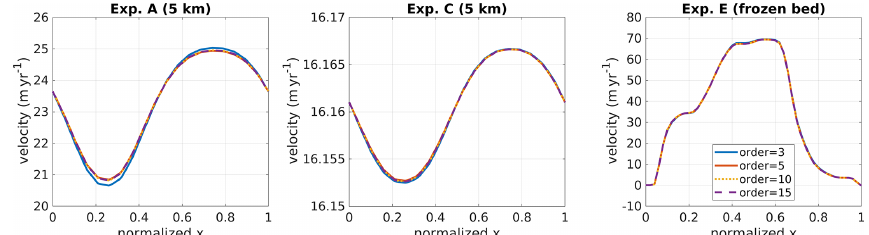
Figure A1. ISMIP-HOM experiments: surface velocities for experiments A, C, and E obtained with the MOLHO model using different inte- gration orders for the ice viscosity computation. Only the short-wavelength (5km) case is shown for experiments A and C. For experiment E, only the frozen bed case is